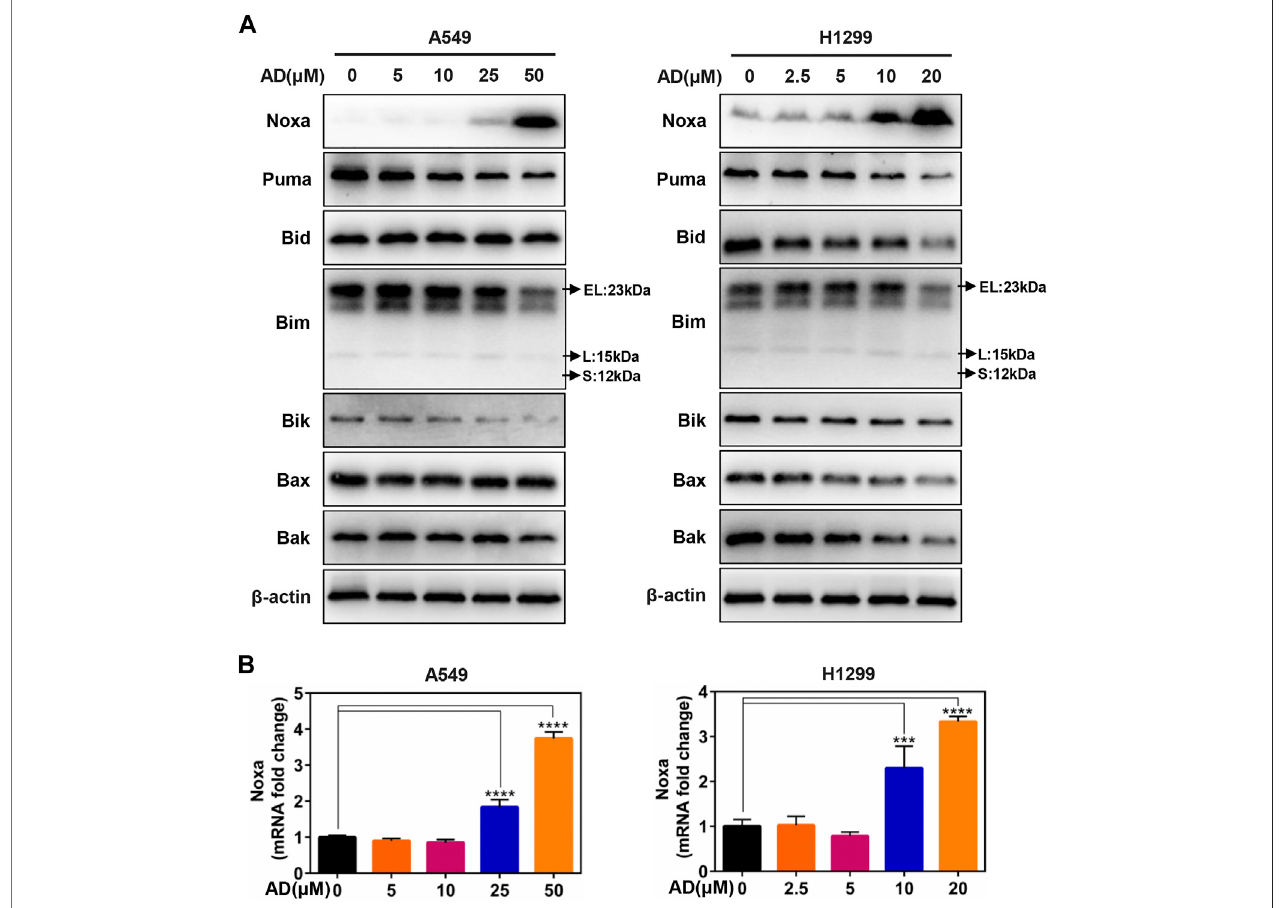
FIGURE 3 | The BH3-only protein Noxa mediated andrographolide-induced apoptosis. (A) Cells were treated with 1 ‰ DMSO or the indicated concentrations of AD for 24 h. Cell protein was extracted and detected by Western blotting with antibodies against Noxa, Puma, Bid, Bim, Bik, Bax, Bak, and β -actin. (B) The mRNA level of Noxa was quanti fi ed by RT-PCR (normalized to β -actin) (*** p ≤ 0.001; **** p ≤